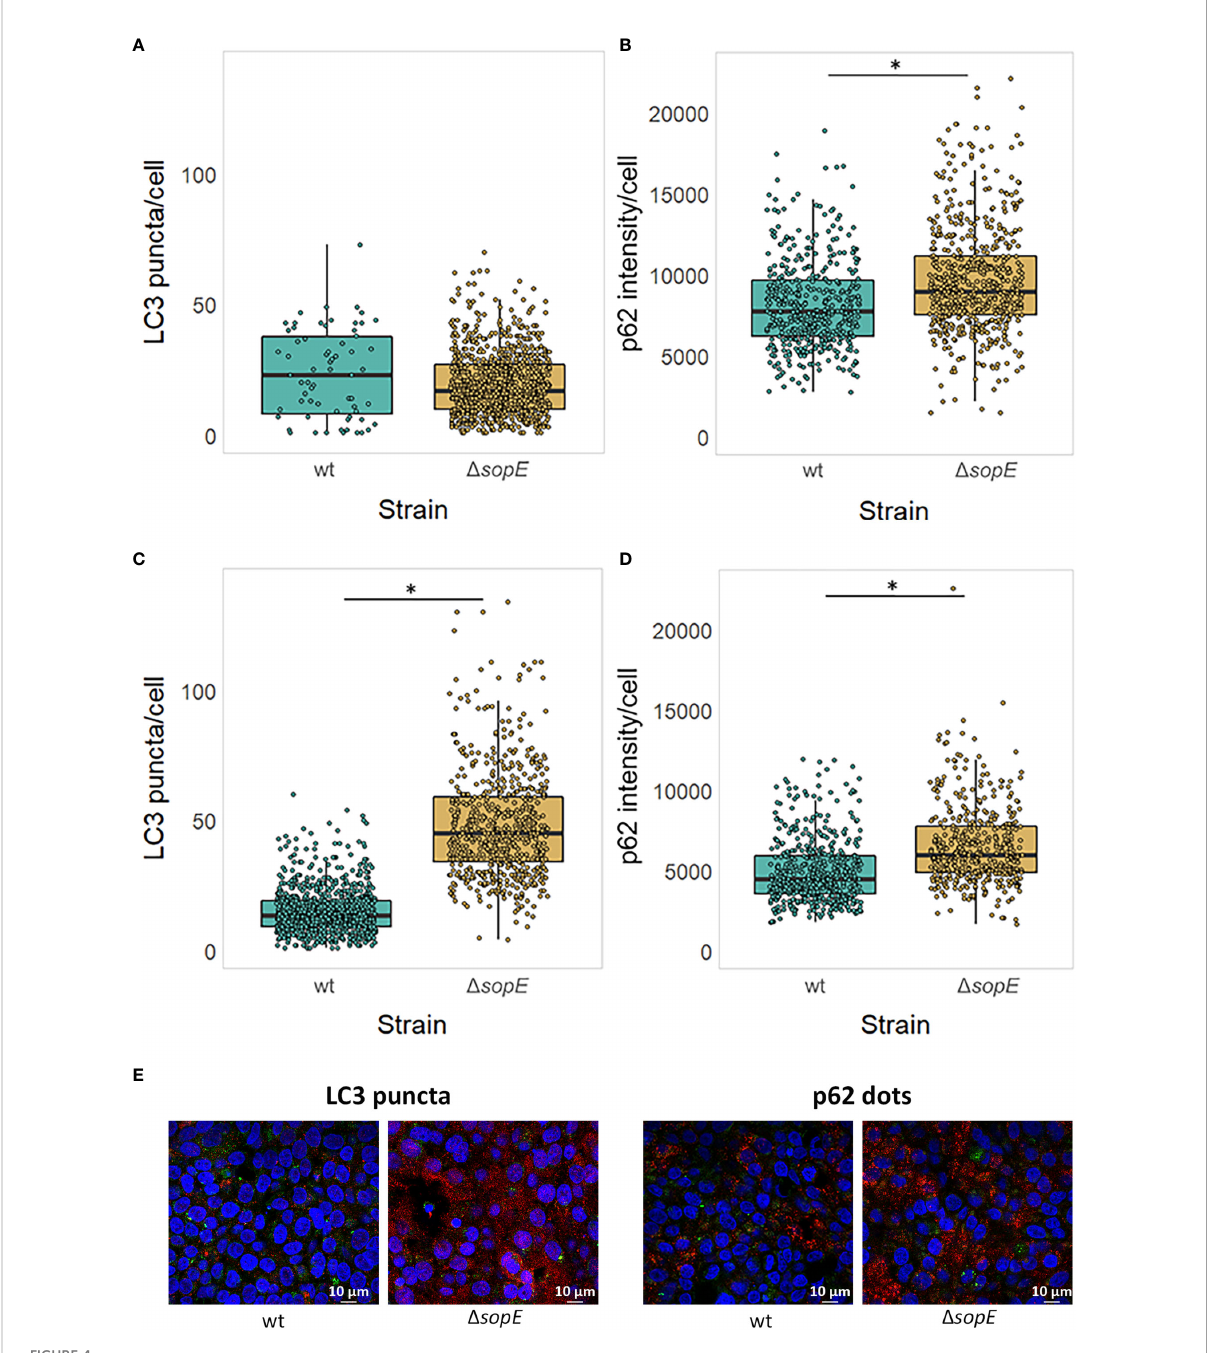
FIGURE 4 SopE dampens the autophagic fl ux by 6h post infection. LC3 puncta number and p62 dot intensity in HT-29 epithelial cells infected for 6h with either wt Salmonella strain or its D sopE gene deletion derivative. (A, B) HT-29 epithelial cells were infected with wt Salmonella and its D sopE gene deletion derivative strain as indicated before. (C, D) HT-29 cells were pre-treated with Rapamycin for 11h prior to and during the 6h-long infection (Maximum 17h). LC3 puncta (A, C) and p62 dot intensity (B, D) was quanti fi ed from HT-29 cells containing Salmonella . *p=0.05. (E) Micrographs of HT-29 cells pre-treated with Rapamycin showing LC3 puncta (red, left) and p62 dots (red, right), intracellular Salmonella cells (green) and nuclei (blue) illustrating panels (C, D)